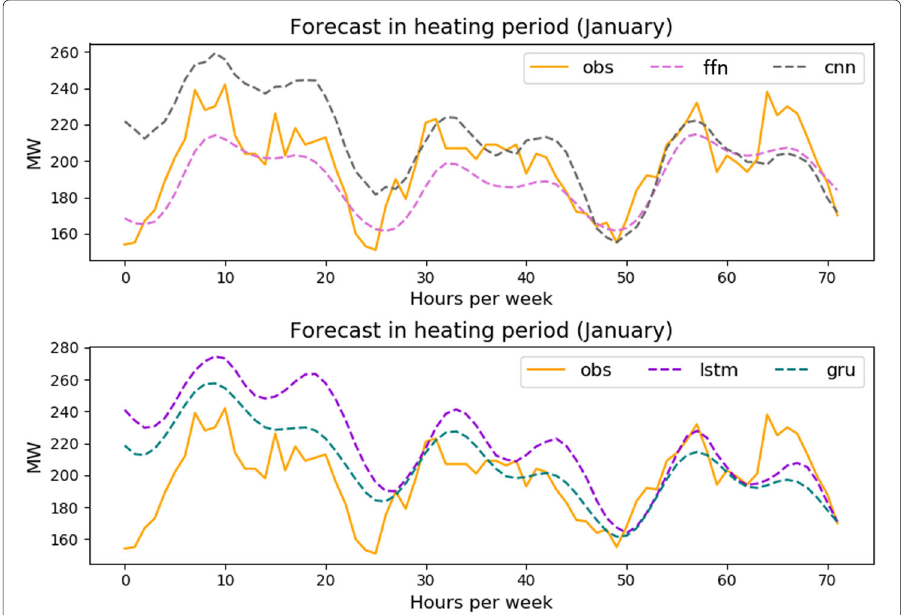
Fig. 1 ANN forecast in heating period for the Flensburg